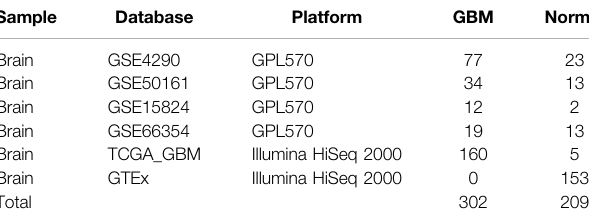
TABLE 1 | Information for GBM